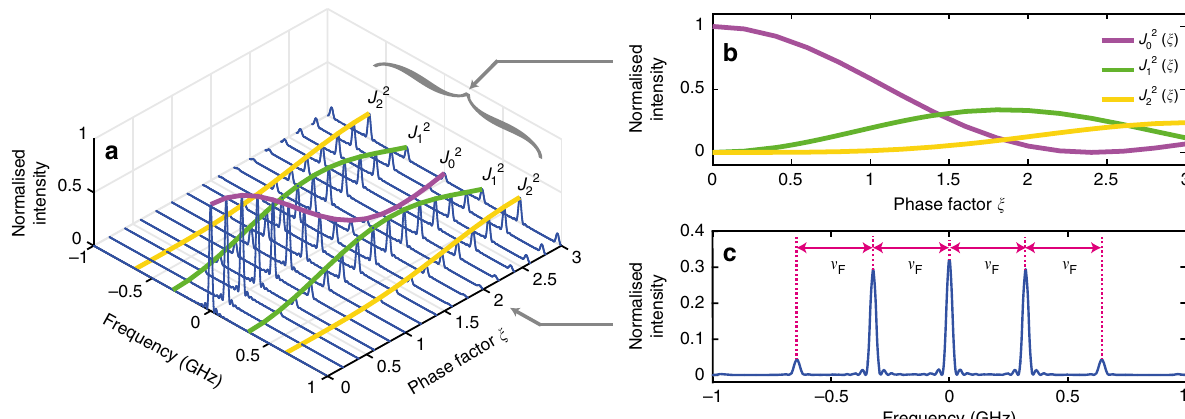
Fig. 3 Simulated longitudinal evolution of the reading pulse spectrum. a The reading pulse spectrum changes along the fi bre as it is being phase modulated by the transverse acoustic wave of forward stimulated Brillouin scattering (FSBS). (For illustration purpose, we assume that the fi bre surroundings is uniform along the fi bre, i.e., the phase factor ξ ( ν F , z r ) increases linearly with respect to the reading pulse location z r . The spectrum is normalised by the input intensity of the reading pulse at its central frequency). b The intensity progression of the 0th, 1st and 2nd order spectral sidebands (each one proportional to J 2 , J 2 and J 2 , respectively) of the reading pulse as a function of the z r -dependent phase factor ξ ( ν F , z r ). c The reading pulse spectrum at an arbitrary 0 1 2 position. Note that the local spectral sidebands are separated by the modulation frequency of FSBS activation